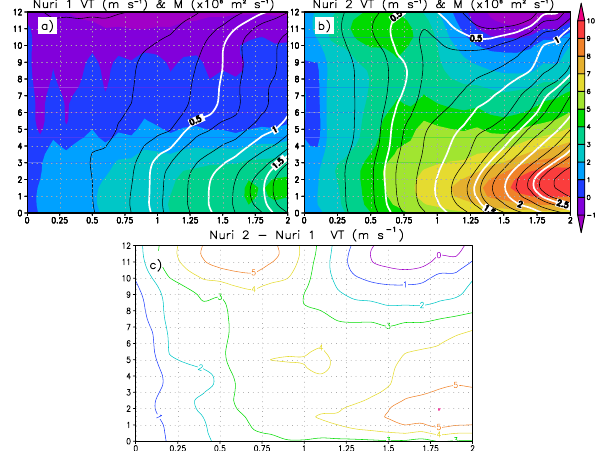
Figure 13. Three-panel plot of tangential wind (top, shaded) and absolute angular momentum (top, contours) for Nuri 1 (a) and Nuri 2 (b) . Angular momentum surfaces are plotted at 0.2 × 10 6 m 2 s − 1 contours (black) and are highlighted (white) at 0.5 × 10 6 m 2 s − 1 intervals. The difference in tangential wind speed between Nuri 2 and Nuri 1 is plotted in (c) . The abscissa is radial distance (degrees) from the 1.5km sweet spot position. The ordinate is height (km).